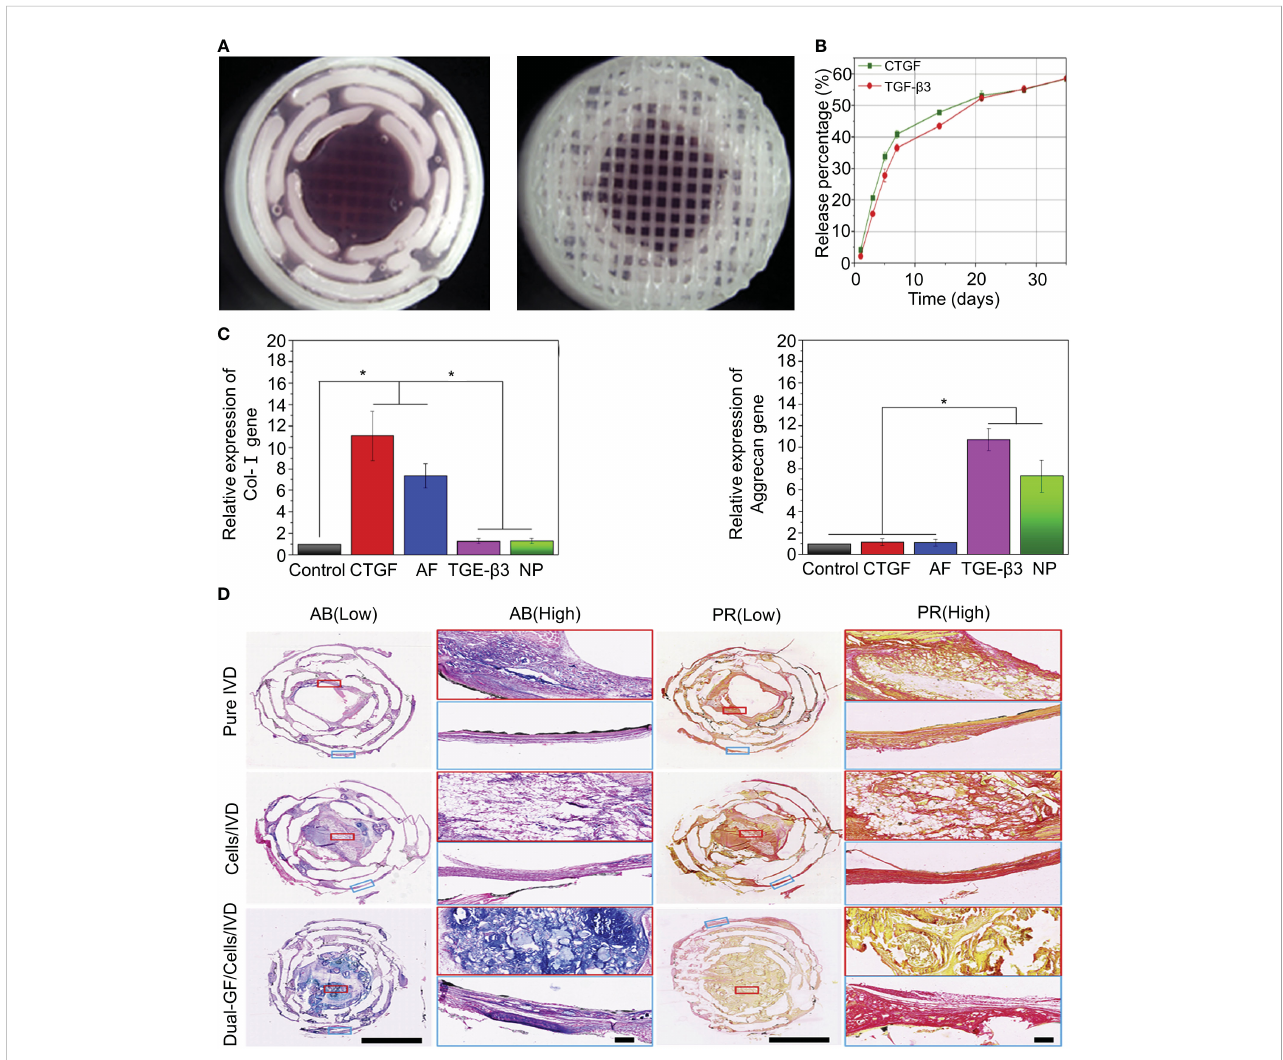
FIGURE 2 (A) Stereomicroscope images of the intermediate and surface structures of the 3D-printed scaffolds. (B) Release behavior of CTGF and TGF- b 3 in the IVD scaffolds. (C) Expression of the type I collagen and aggrecan genes after inducing differentiation in different groups. (D) Histological staining of the intermediate layers of three IVD scaffolds with AB and PR dyes. Magni fi ed images at low and high magni fi cation. AB and PR dyes speci fi cally stained GAG (blue) and type I collagen (red), respectively. Reproduced with permission from (42). *Indicates signi fi cant difference at a 99 %con fi dence